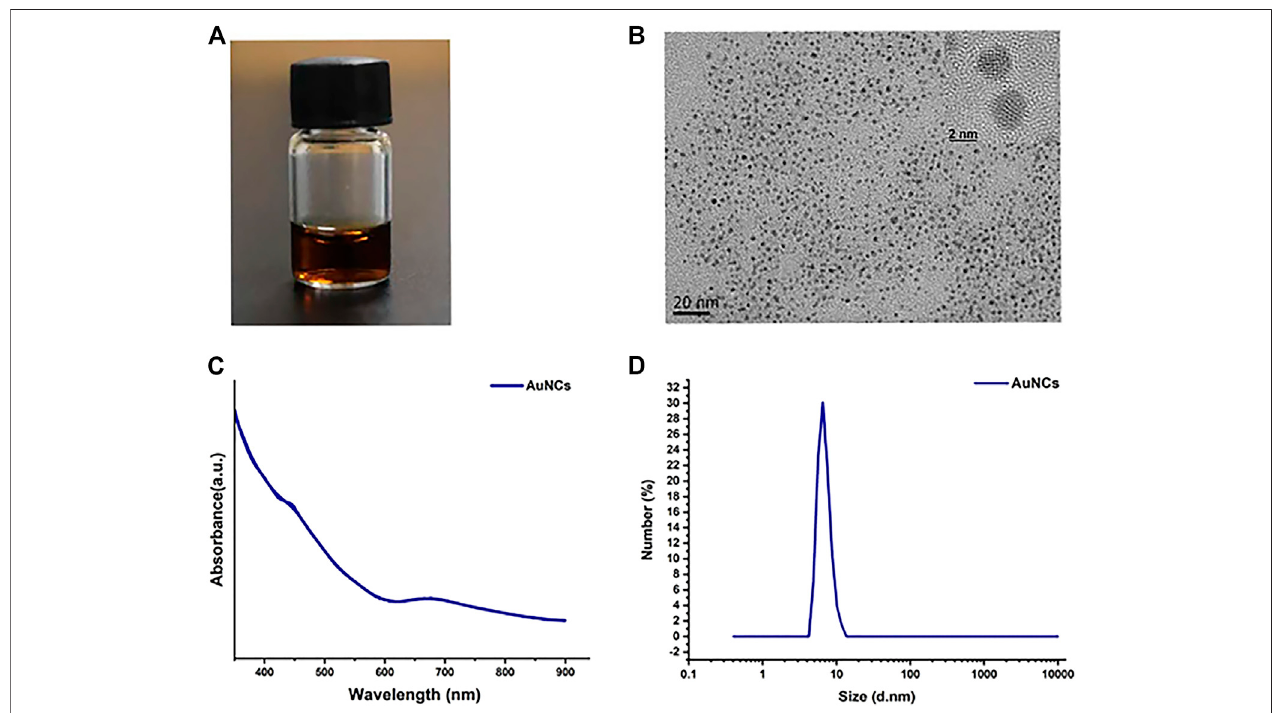
FIGURE 1 | Characterization of AuNCs. (A) A photograph of AuNCs solution. (B) Transmission electron microscopic (TEM) and HR-TEM images. (C) UV-vis absorption spectra. (D) DLS size distribution.